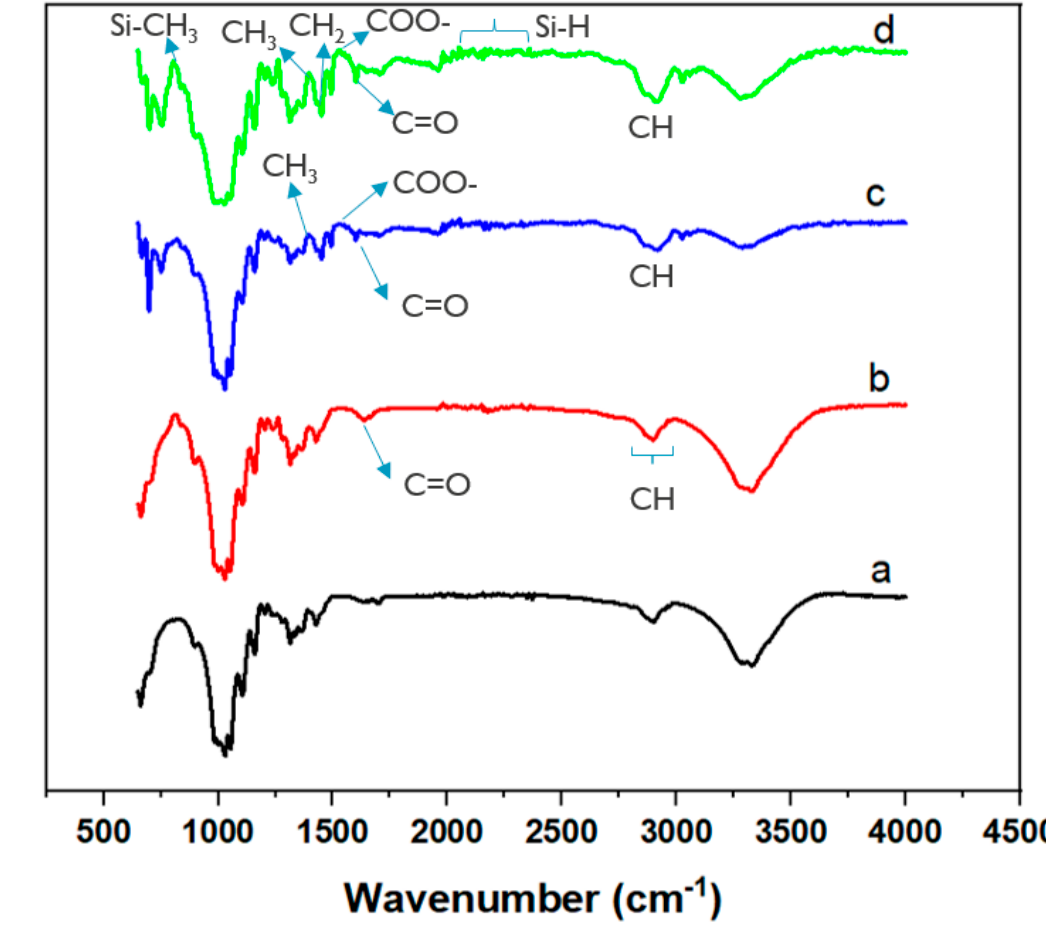
Figure 3. ATR-FTIR spectroscopy of (a) pristine cotton, (b) O 2 plasma pre-treatment, (c) Si- Cot_Dip/O 2 , (d) Si-Cot_Plasma/O 2 samples.